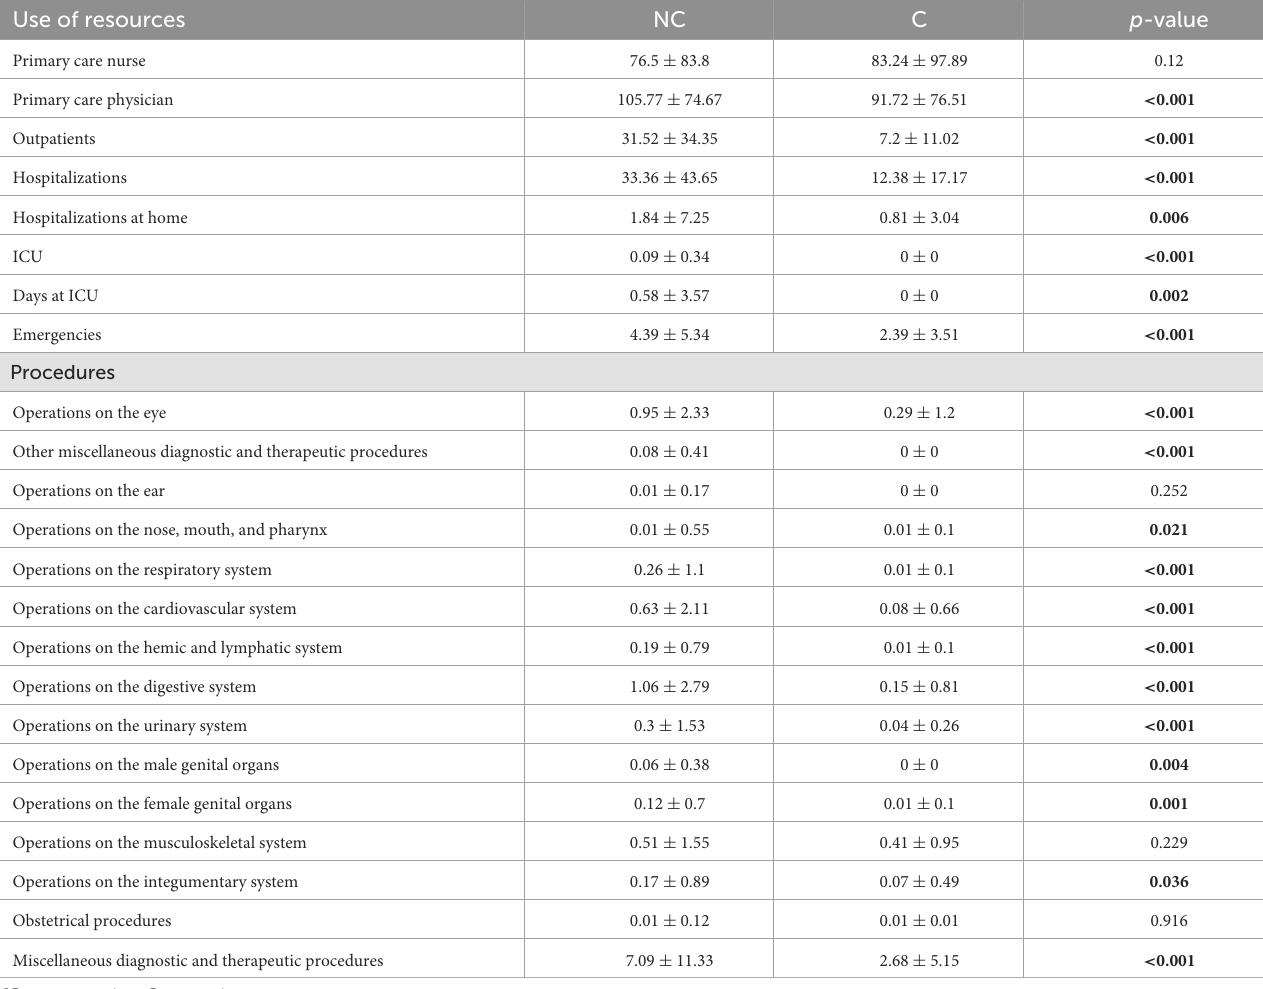
TABLE 3 Use of resources for centenarians and non-centenarians. Mean ±